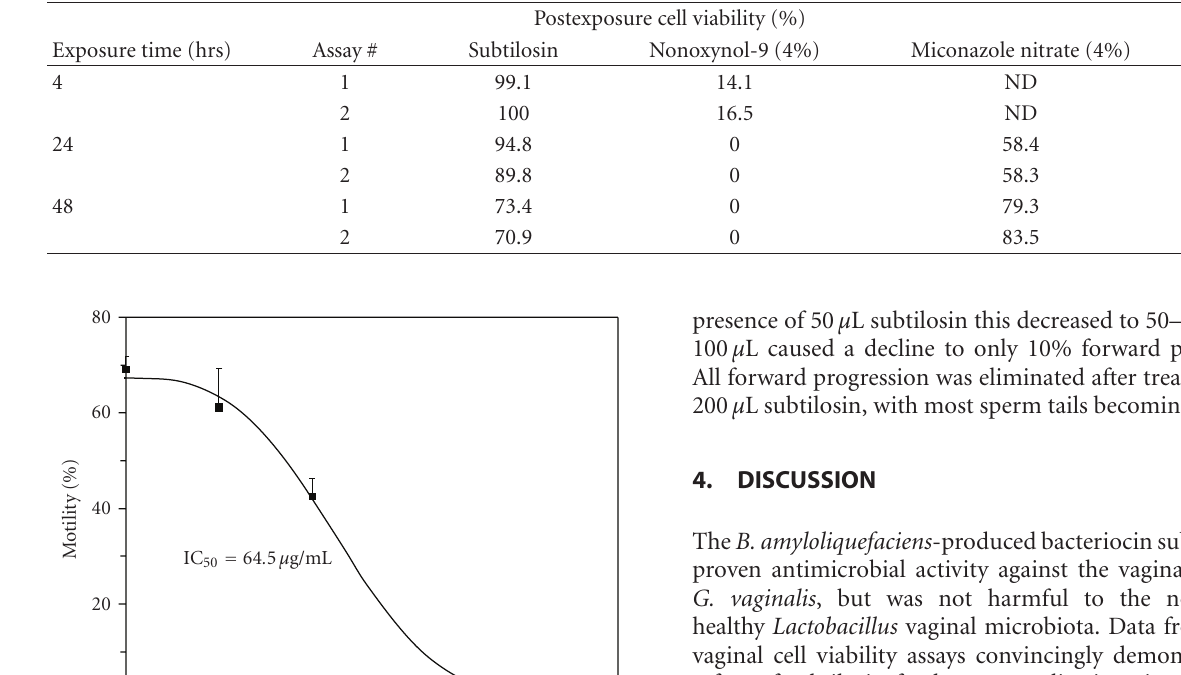
Table 1: Ectocervical cell viability after prolonged exposure to subtilosin.